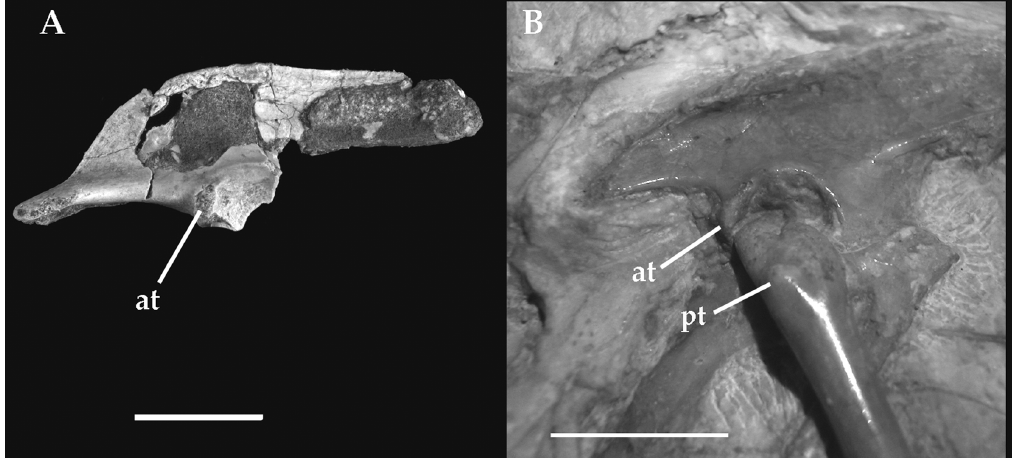
Fig. 3 – Right pelvic girdle of: A , Buitreraptor gonzalezorum (MPCA, 245; holotype); B , Archaeopteryx lithographica (HMN, 1880). Scale bar 1 cm. Abbreviations: at, antitrochanter; pt, posterior trochanter of